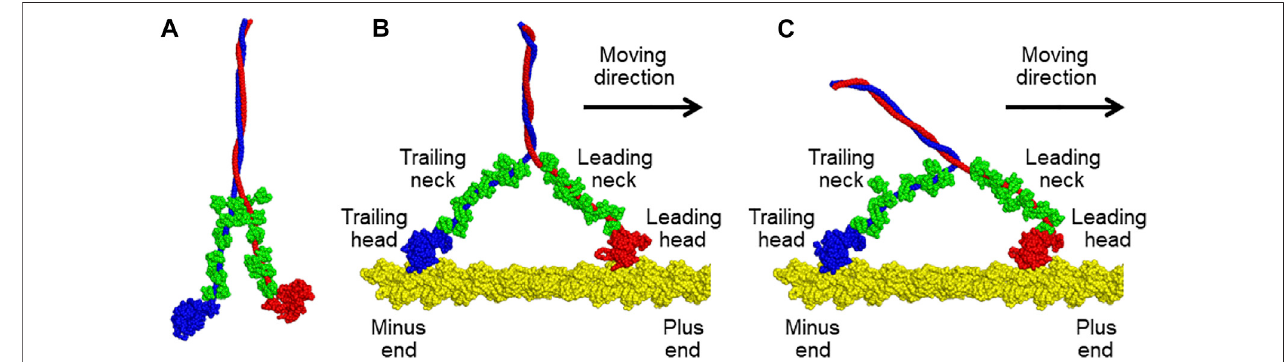
FIGURE 1 |(A) Molecular model of a tail-truncated myosin V. (B,C) Molecular models ofthe complexes of an actin fi lament with myosin Vin (B) the down-up state and (C) down-downstate.TwoheavychainsofmyosinVareshowninblueandred.TwelvelightchainsofmyosinVincompactorextendedconformationsarecoloredin green. The actin fi lament is indicated in yellow. All structures were drawn using PyMOL version 1.8.4.0